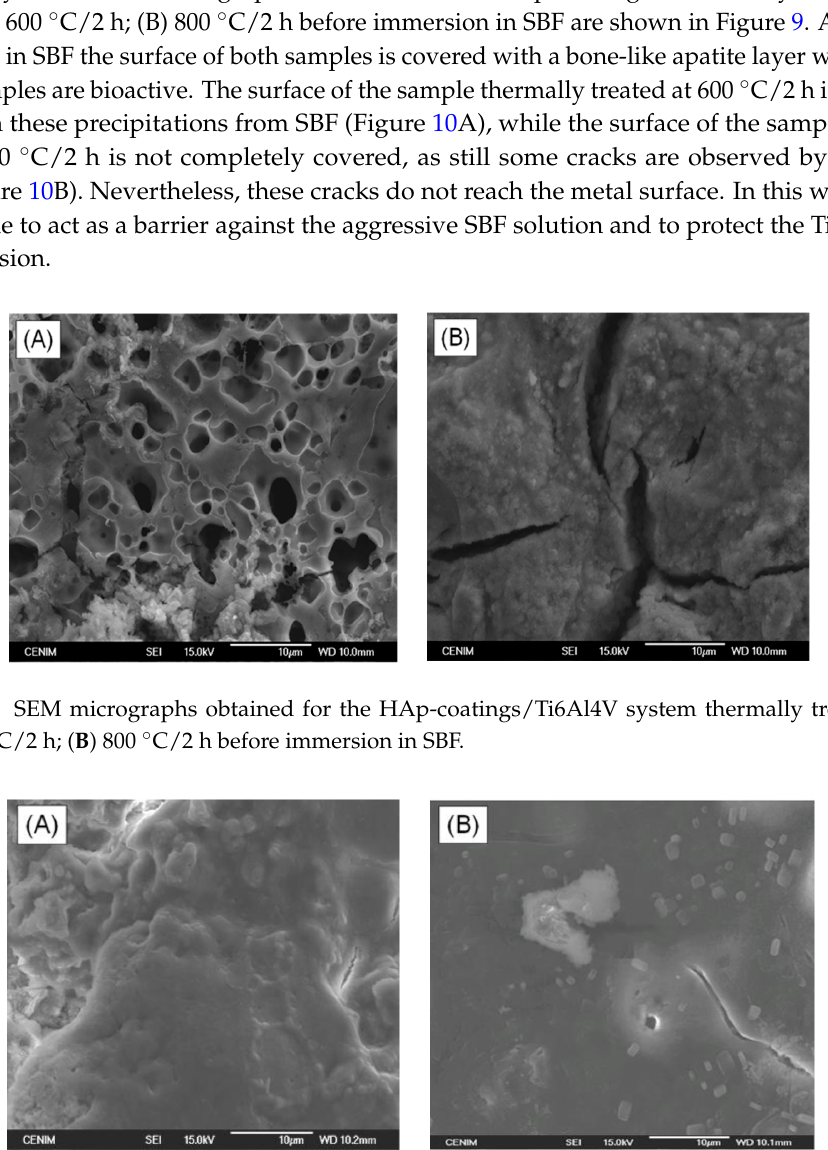
Figure 10. SEM micrographs obtained for the HAp-coatings/Ti6Al4V system thermally treated at ( A ) 600 °C/2 h; ( B ) 800 °C/2 h after immersion in a SBF solution.